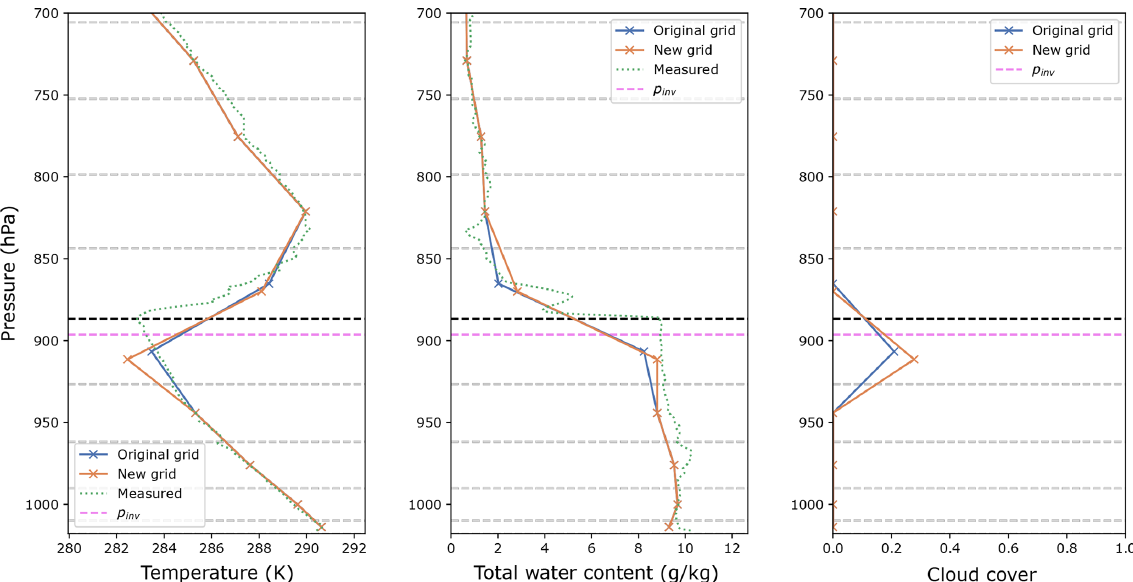
Figure 4. Example vertical profiles of the EPIC SCM experiment obtained with the original and new (refined) model grid and observed profiles at the end of day 5 (hour 118). The grey dashed lines represent half-levels common to both grids. The black dashed line represents the top of the ambiguous layer on the original grid; it is shifted to the inversion pressure (magenta dashed line) for the refined grid. Table 1. Annual mean total cloud cover and differences between simulations, as global and regional averages. An asterisk denotes statistically significant differences at the 95% significance level. “ (cid:49) seen by rad.” indicates the change in total cloud cover produced with invgrid, which is then applied only in the radiation routine. The abbreviations used in this table (and in subsequent tables throughout the paper) are as follows: North America (NAM), South America (SAM), southern Africa (AFR), and the Barents Sea (BAR). Total cloud cover Global NAM SAM AFR BAR CALIPSO (%) 67.2 69.1 71.7 66.5 82.6 66.4 63.0 58.3 58.2